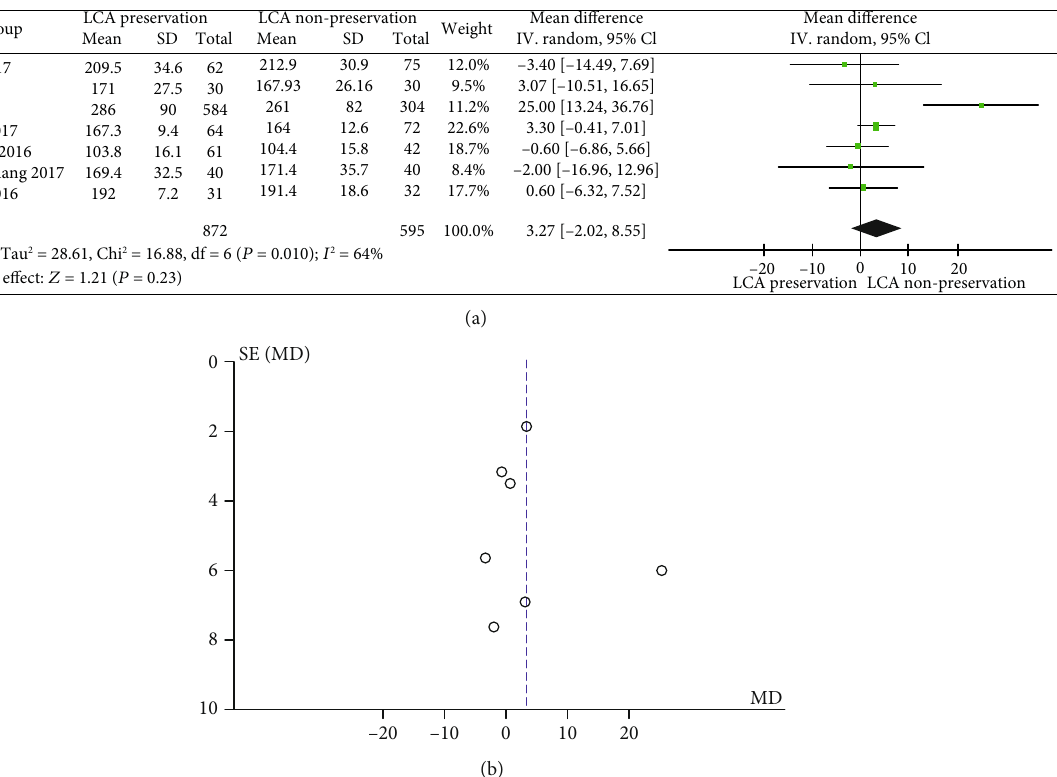
Figure 3: (a) Forest plot of duration of surgery; (b) funnel plot of duration of